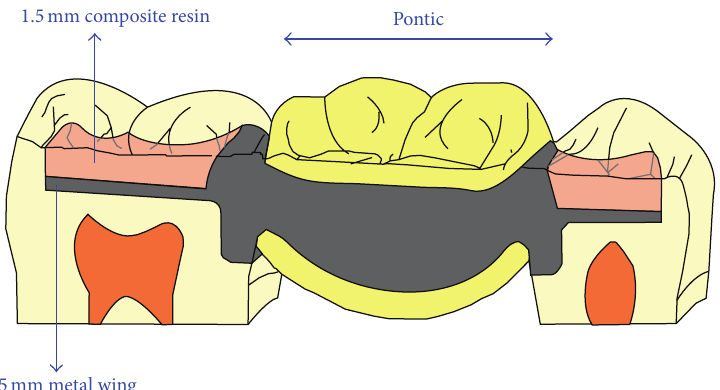
Figure 2: A cross sectional lingual view of the of the modified metal-ceramic IRFDP and its relation to the supporting dental